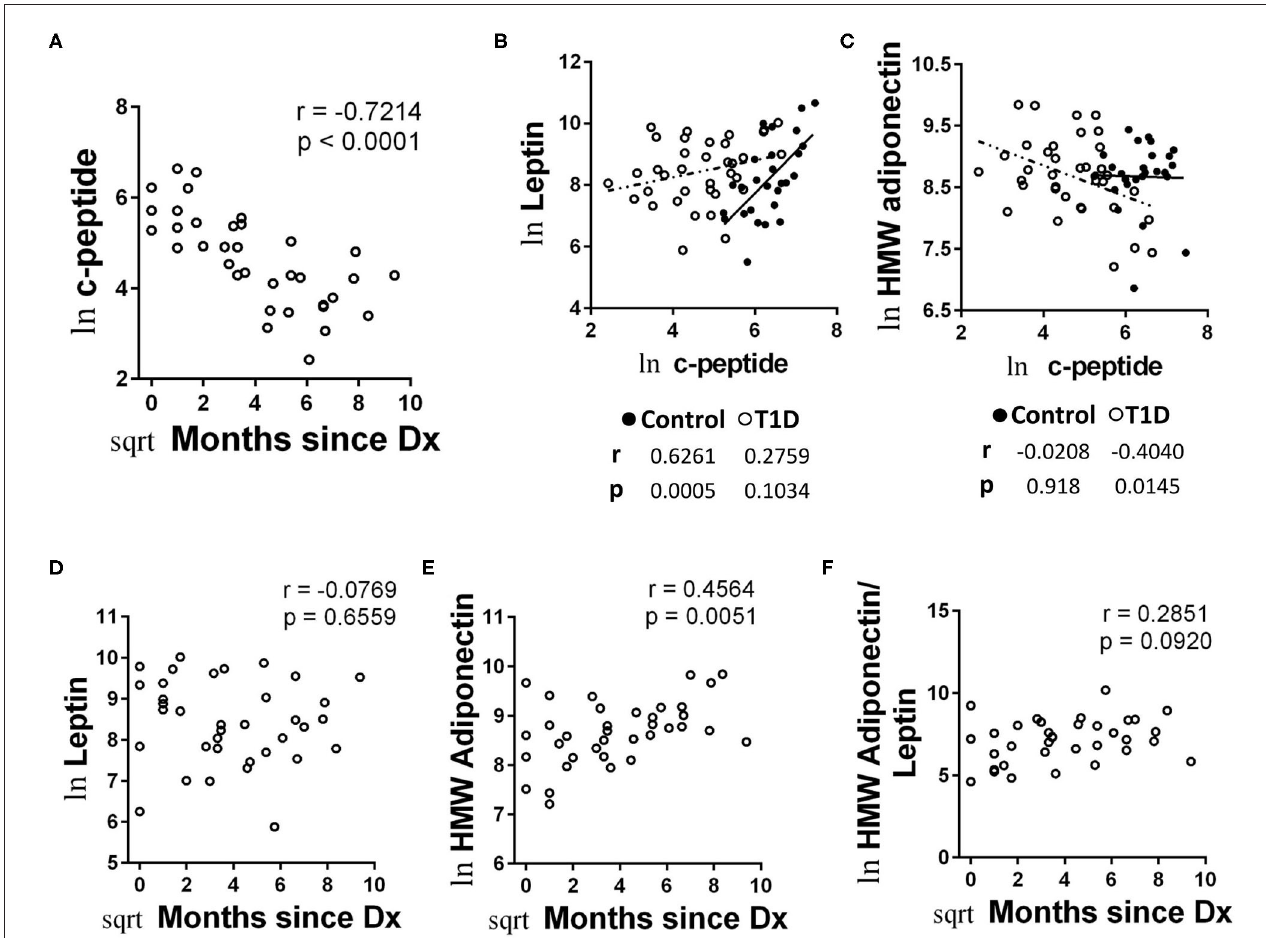
FIGURE 8 | Unique associations with c-peptide and adipokines among T1D subjects and increasing HMW adiponectin with time since diagnosis. (A) C-peptide levels rapidly decrease with months since diagnosis. (B) Leptin levels were positively and significantly associated with c-peptide levels in controls, while the relationship was weaker among T1D subjects and did not reach significance. (C) HMW adiponectin was not significantly associated with c-peptide levels among controls, while T1D subjects possessed a negative and significant association between HMW adiponectin and c-peptide. (D) Leptin levels were not significantly associated with time since diagnosis amount T1D subjects. (E) HMW adiponectin levels increase with time since diagnosis among T1D subjects. The results were similar for total adiponectin (data not shown). (F) The ratio of HMW adiponectin to leptin was weakly associated with time since diagnosis, but did not reach significance. Data were normalized using natural logarithm (ln) and square root (sqrt)